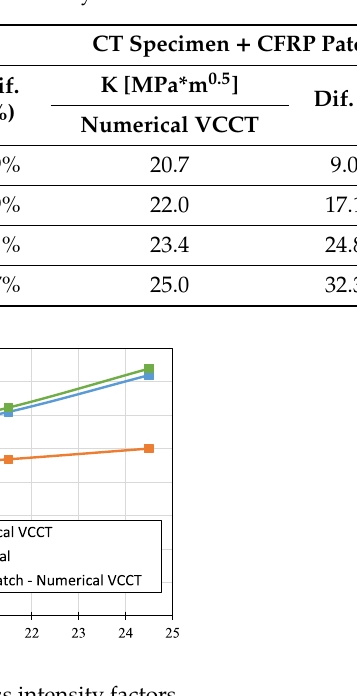
Table 4. Comparison of final stress intensity factors.